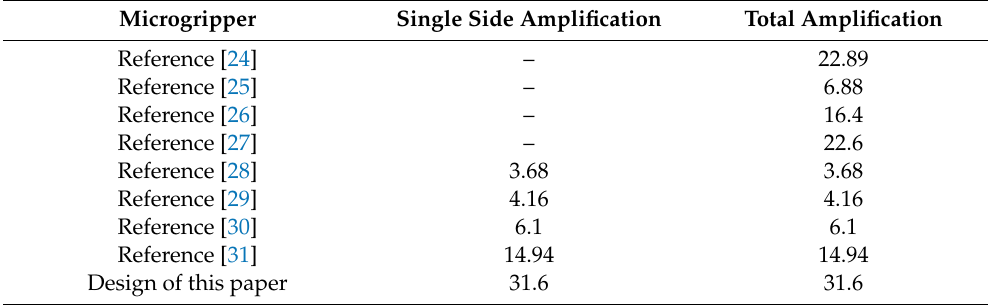
Table 3. Comparison of the parameters of similar microgrippers.